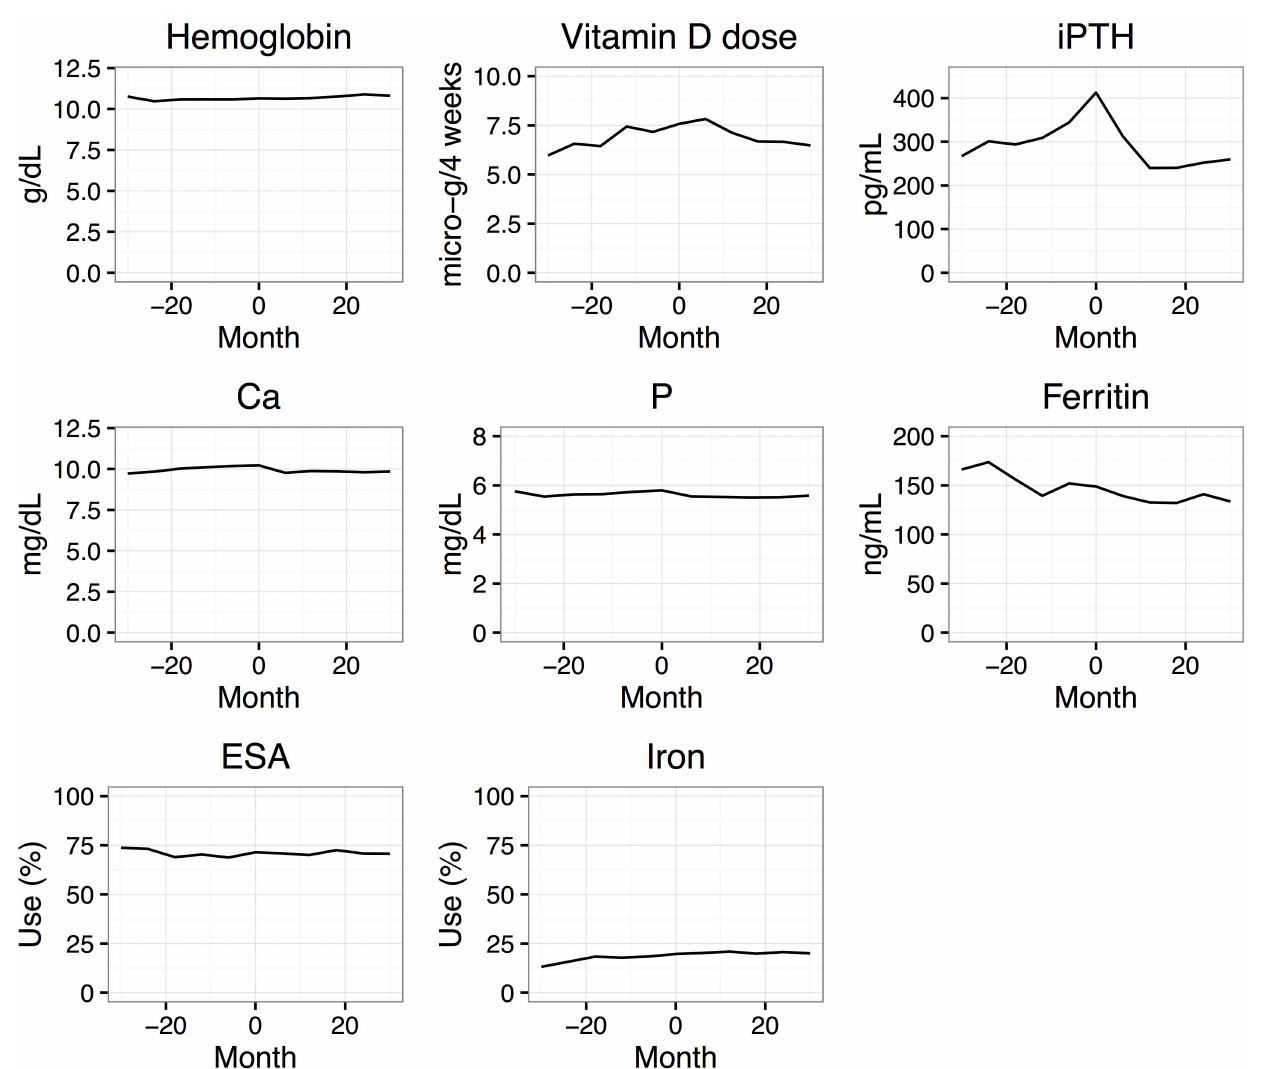
Fig 2. Trajectories of laboratory findings and medication use for the cinacalcet users before and after cinacalcet initiation.